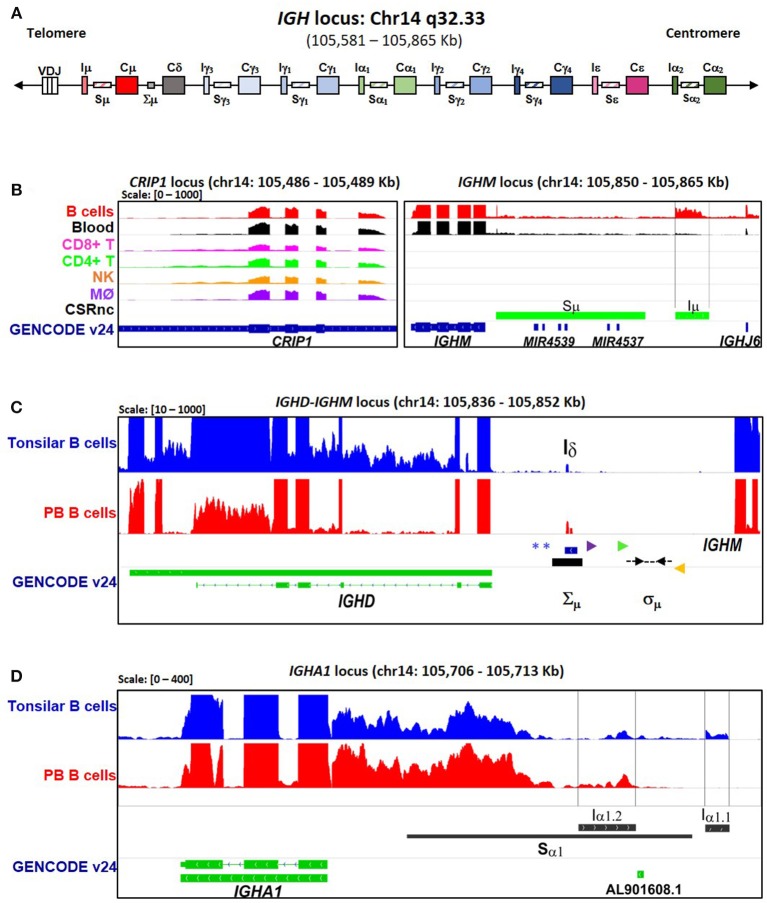
CSRnc transcription boundaries definition. Selected projects using isolated B cells were used to define the limits of CSRnc transcription in human chromosome 14 (See Table S1). (A) Schematic representation (not on scale) of the IgH locus in a VDJ rearranged B cell, including i-exons (IH, CSRnc transcripts), switch regions (SH, horizontal rectangles), and coding exons of the constant region (CH, large rectangles). The telomeric region is toward the left. BigWig files were downloaded using recount2 and visualized using IGV (18) to inspect to determine the boundaries for each CSRnc transcript. (B) Coverage graph of project SRP045500 showing the CRIP1 locus (left panel) and the IGHM locus (right panel) in B (red track) and non-B cells. The CRIP1 gene is transcribed in B and non-B cells, whereas IGHM and Iμ (within black vertical lines) is transcribed only in B cells and in peripheral blood (Black track). Predicted Sμ region is shown in the bottom track (blue) and annotated genes (GENCODE v24) are shown in green. (C) A view of the IGHM—IGHD intron locus displaying coverage graphs from normal purified naive tonsillar (SRP021509, blue track) and peripheral blood CD19+ B cells (SRP060715, red track). The vertical black arrow shows Iδ. IGHD annotation GENCODE v24 is shown in green. The Iδ exon overlaps with the Σμ region (20, 21, 22) and is centromeric regarding the mapped sites for μ–δ CSR junctions (Dotted black arrows) (21). Antisense primer (18156) used by Kluin et al. (21) and Arpin et al. (P4) (22) are shown in purple and green, respectively. The Sδ Sense primer used by Chen et al. (23) is shown in orange. The blue asterisks indicate Hind III sites (20, 24, 21). (D) Transcriptional landscape of the IGHA1 locus displaying coverage graphs of the IGHA1, GENCODE v24 annotation (green track), tonsillar naive (SRR834982, blue), and peripheral blood B cells (SRR2097501, red). Both Iα1.1 and Iα1.2 transcripts are shown. The Sα1 region (black bar) is shown. For B–D, coverage scale is shown in the left upper corner within brackets.